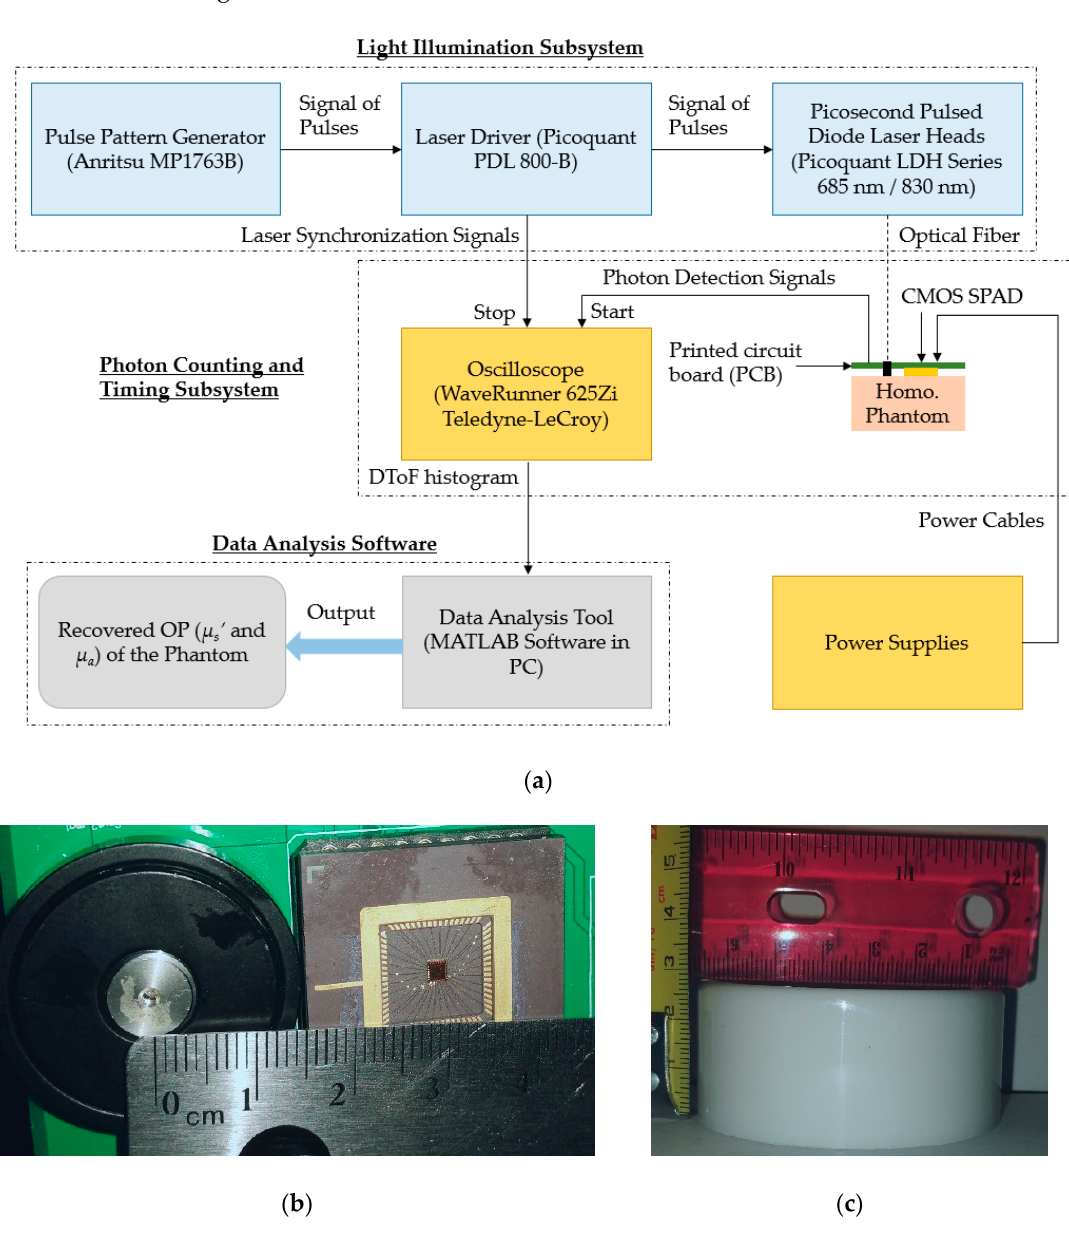
Figure 2. ( a ) Diagram of main components of the TR-DOS prototype; ( b ) light source and detector arrangement (28 mm source-detector distance) that are attached to the surface of phantoms; ( c ) a sample of the homogeneous phantoms.